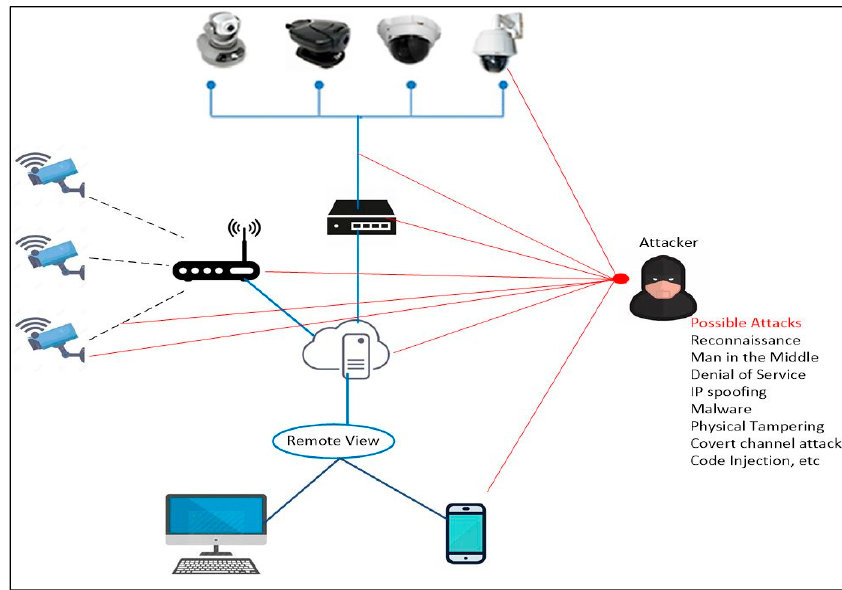
Figure 5. Pervasive attacks on VSS.